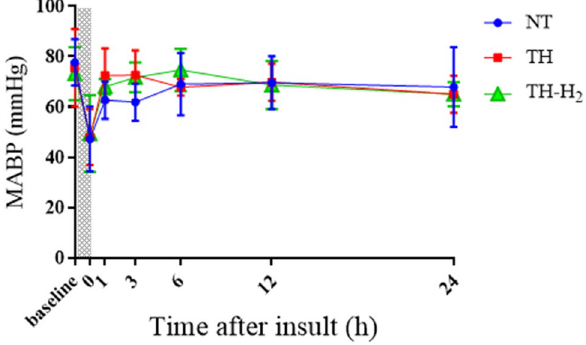
Figure 4. Mean blood pressure (MABP, mmHg) at the end and at 1, 3, 6, 12, and 24 h after hypoxic-ischemic insult in normothermia (NT, n = 10), therapeutic hypothermia (TH, n = 8), and TH with hydrogen gas inhalation (TH + H 2 , n = 8) groups.